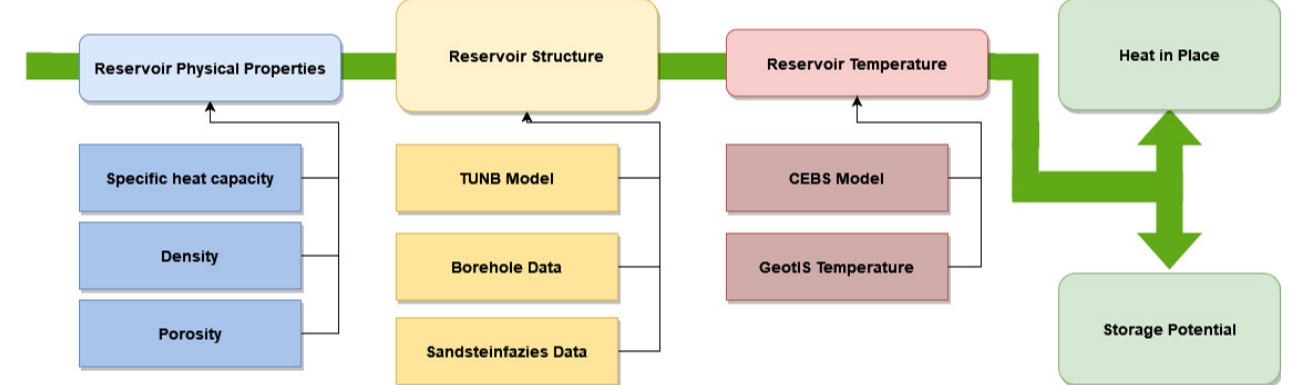
Figure 1. Applied workflow. Input data in blue, yellow, and red; output data in green. TUNB model = structural model of the North German Basin [31], Sandsteinfazies data = structural data from the Sandsteinfazies project [30] CEBS Model = temperature model of the Central European Basin System [32], GeotIS Temperature = temperature model from the Geothermal Information System [25].